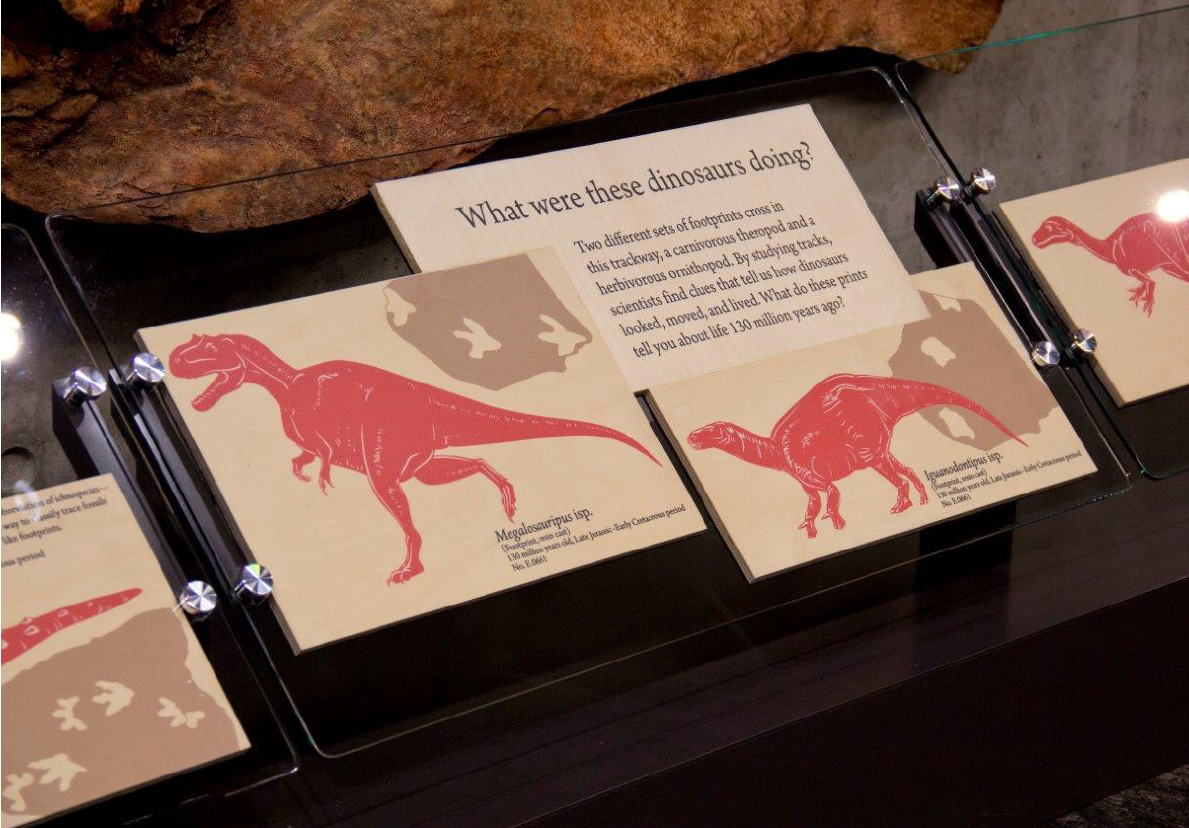
Figure 2. Detail of the Footprints in Time exhibit, showing the stories that the exhibit